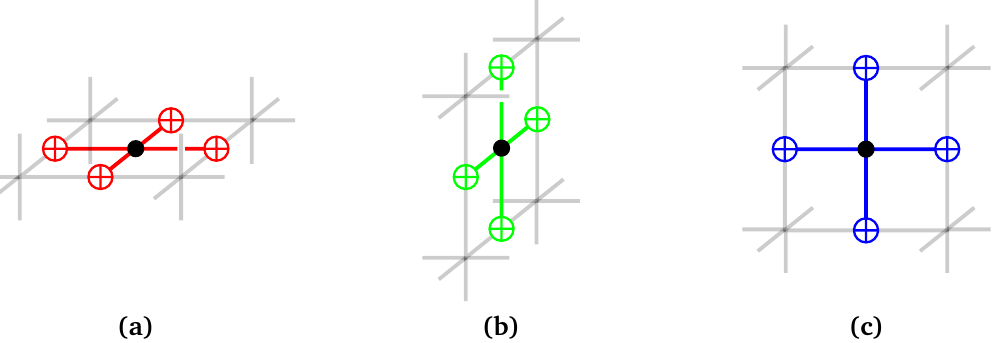
Figure 7: The three components of the unitary transformation given in Eq. (23). The solid dot in the center of each plaquette represents the control qubit for the target qubits on the